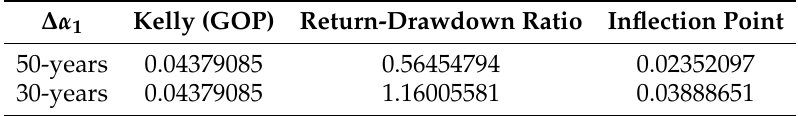
Table 4. Percentage change of 15-year loan allocation when Fed fund rate increases by 0.25%.